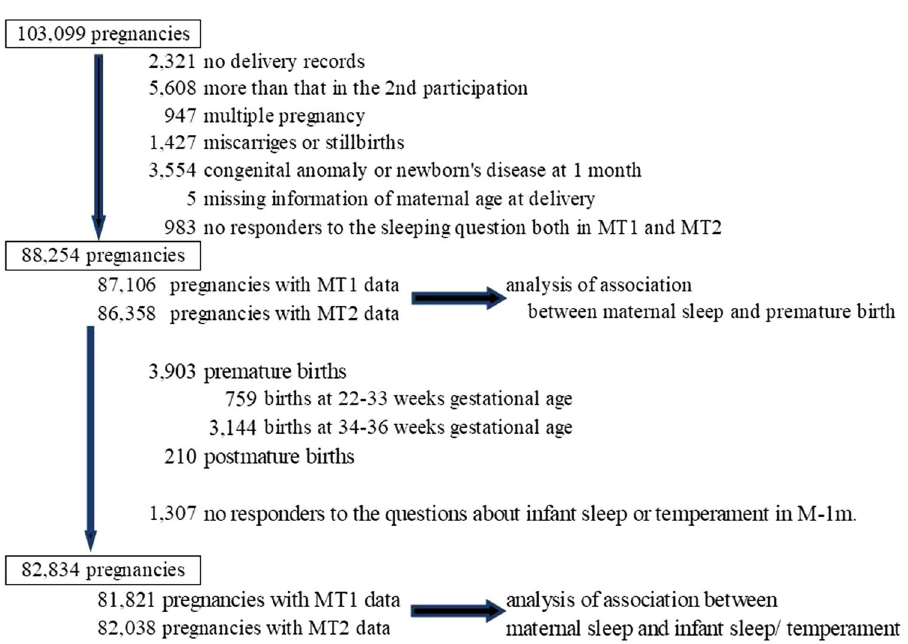
Figure 1. Flow chart representing the study population. M-T1: questionnaire administered at recruitment; M-T2: questionnaire administered during mid- and late-pregnancy; M-1m: questionnaire administered at 1 month after